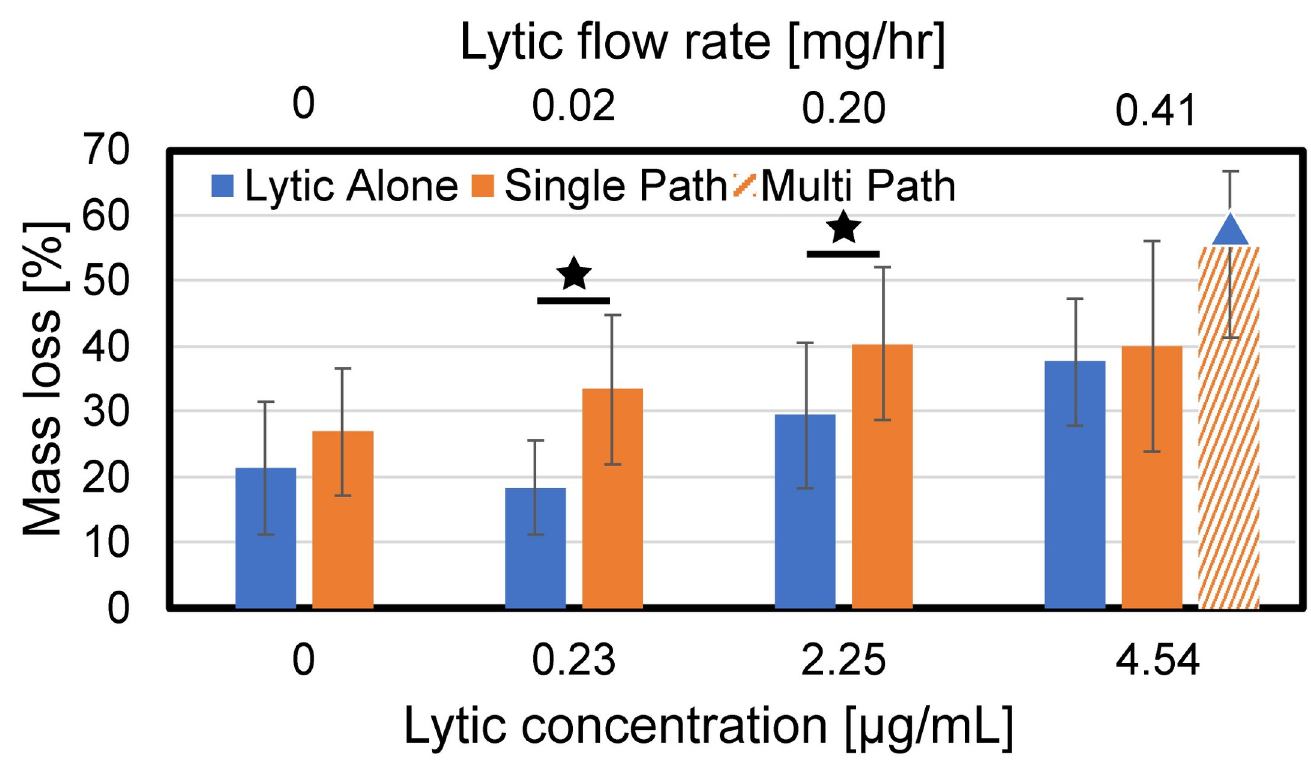
Fig 3. Clot mass loss for the treatment arms tested in this study as a function of the lytic rt-PA concentration. The legend indicates the insonation scheme (histotripsy was not applied for the ‘Lytic Alone’ arm). Stars indicate statistically significant increases in mass loss for a given rt-PA dose (p < 0.05). The blue triangle indicates an increased mass loss compared to the standard of care arm (4.54 μ g/mL rt-PA only).